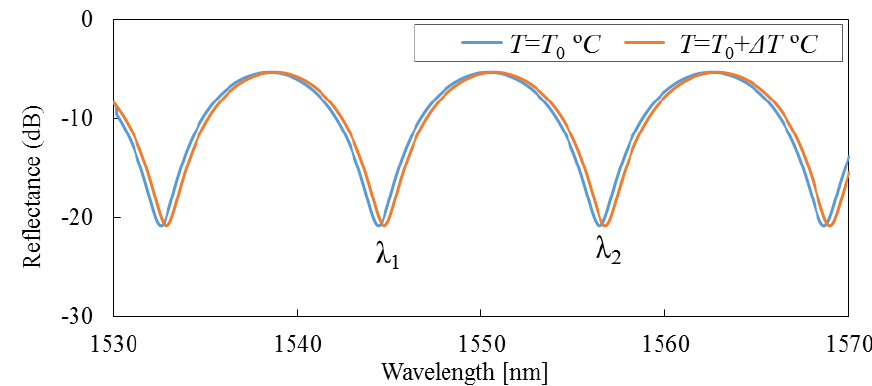
Figure 3. Comparisons of the interference spectra at a temperature difference ΔT = 500 °C, where all other parameters remain unchanged, that is R 1 = 0.1, R 2 = 1.0, α = 0.5, β = 0.5, l = 100∙[1 + C ·( T − T 0 )] µm, Figure 2. Reflection spectra calculated for RI of n = 1.0 (less than RI of silica), n = 1.46 (approximately and C is the linear thermal expansion coefficient of silica fiber, set as 4×10 −7 /° C . equal to RI of silica), and n = 1.6 (greater than RI of silica), respectively.